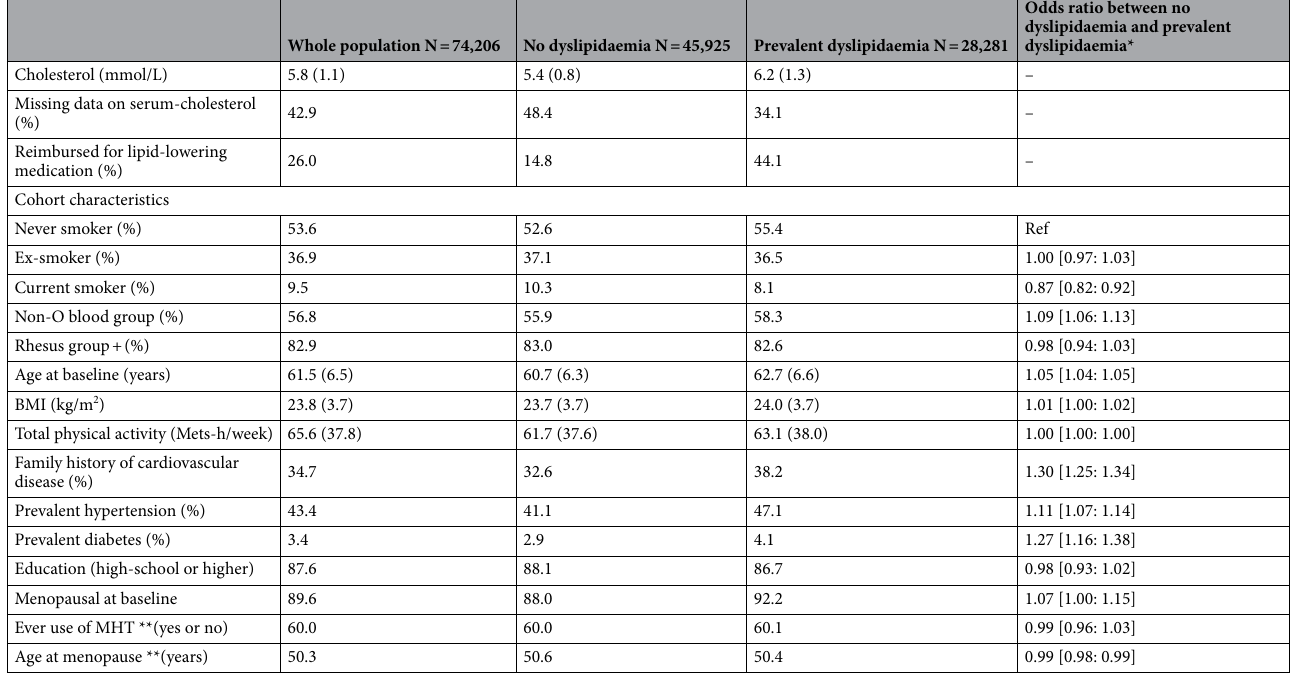
Table 1. Associations between baseline characteristics and prevalent dyslipidaemia, odds ratio calculated using a mutually adjusted logistic regression model. *Adjusted simultaneously for all variables. **Amongst